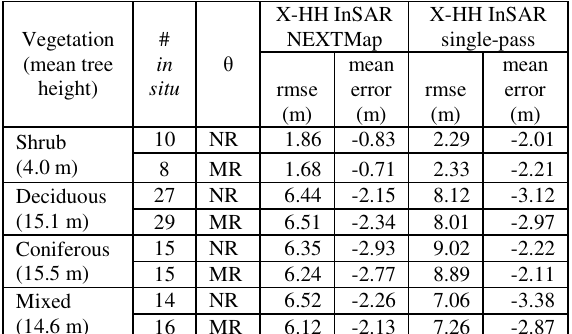
Table 1. NEXTMap and single-data take X-HH InSAR-derived h spc error assessment against in situ vegetation canopy height for the Ely site, stratified by vegetation cover type and incidence angle range for <10 º terrain slope.